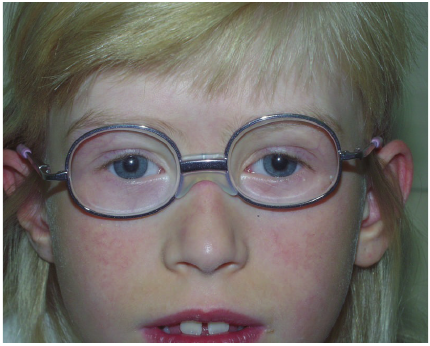
Figure 3: Facial features at age 8 years. Result of ophthalmological treatment: parallel position of the eyeball with final correction OD 5PD, OS